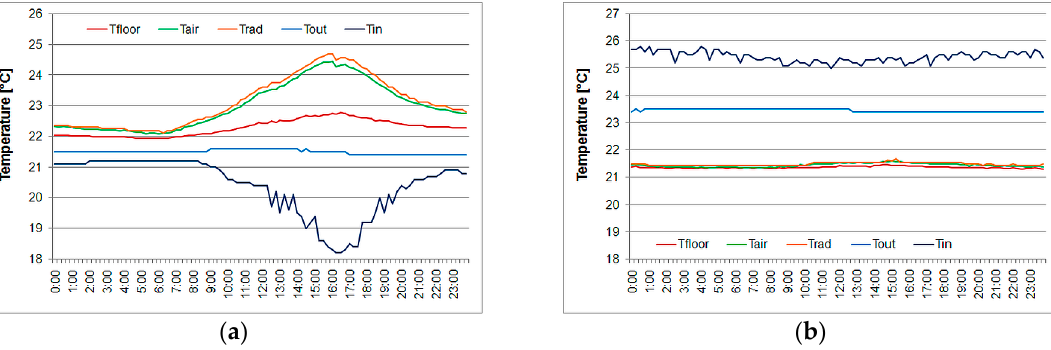
Figure 24. Measured floor (Tfloor), air (Tair), radiative (Trad), outlet water (Tout) and inlet water (Tin) temperatures on holidays: ( a ) 4 August 2019; ( b ) 10 November 2019.